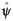
Vermilion Flycatcher Pyrocephalus rubinus occupancy (ψ^) in the regional bird monitoring area in Argentina.Occupancy of the species is represented for (a) 2003, (b) 2006, (c) 2009, (d) 2012.